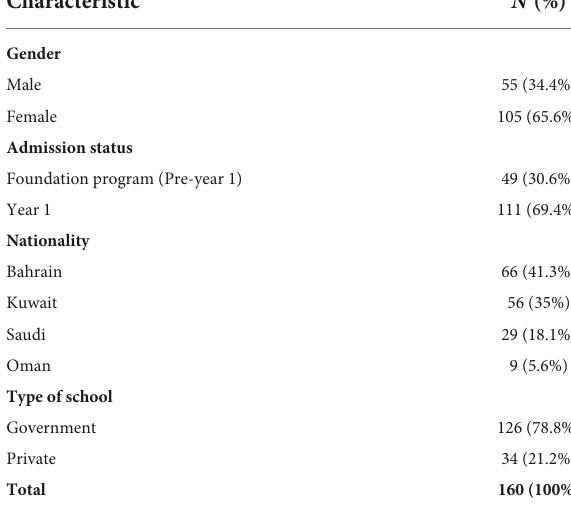
TABLE 1 Demographic data of the graduate students ( n =